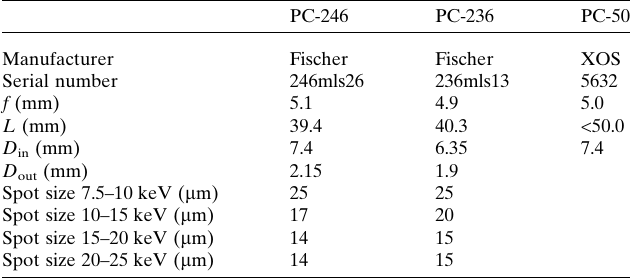
Table 1 Properties of the investigated polycapillary optics as given by the manufacturers.